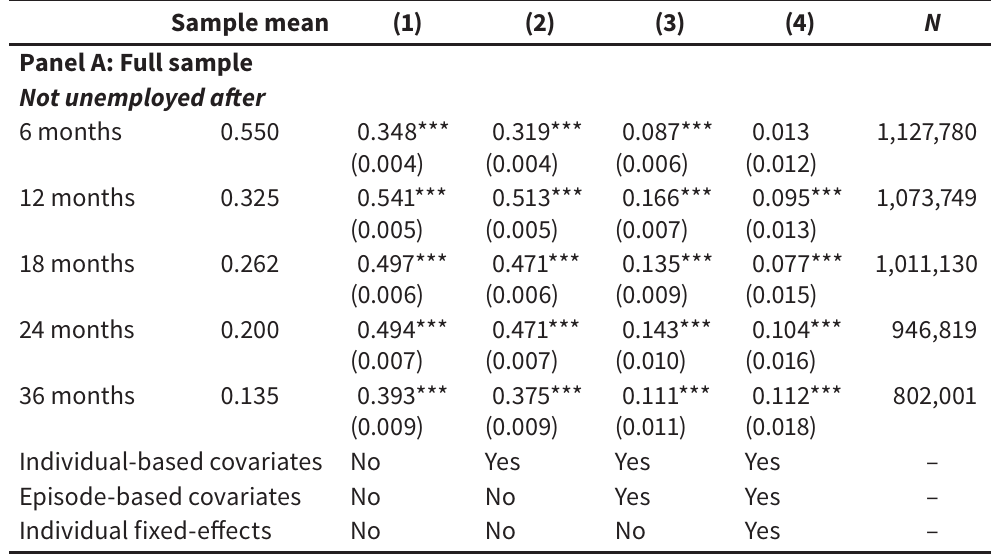
Table A3 Results, unemployment re-entry: episodes by individuals with at least two appearances in the